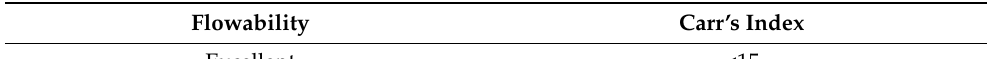
Table 4. Classification of Carr Index